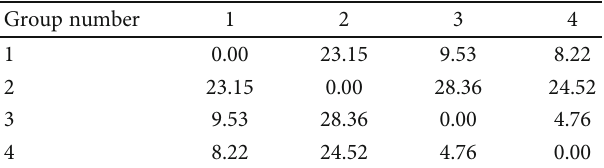
Table 3: Mahalanobis distances.